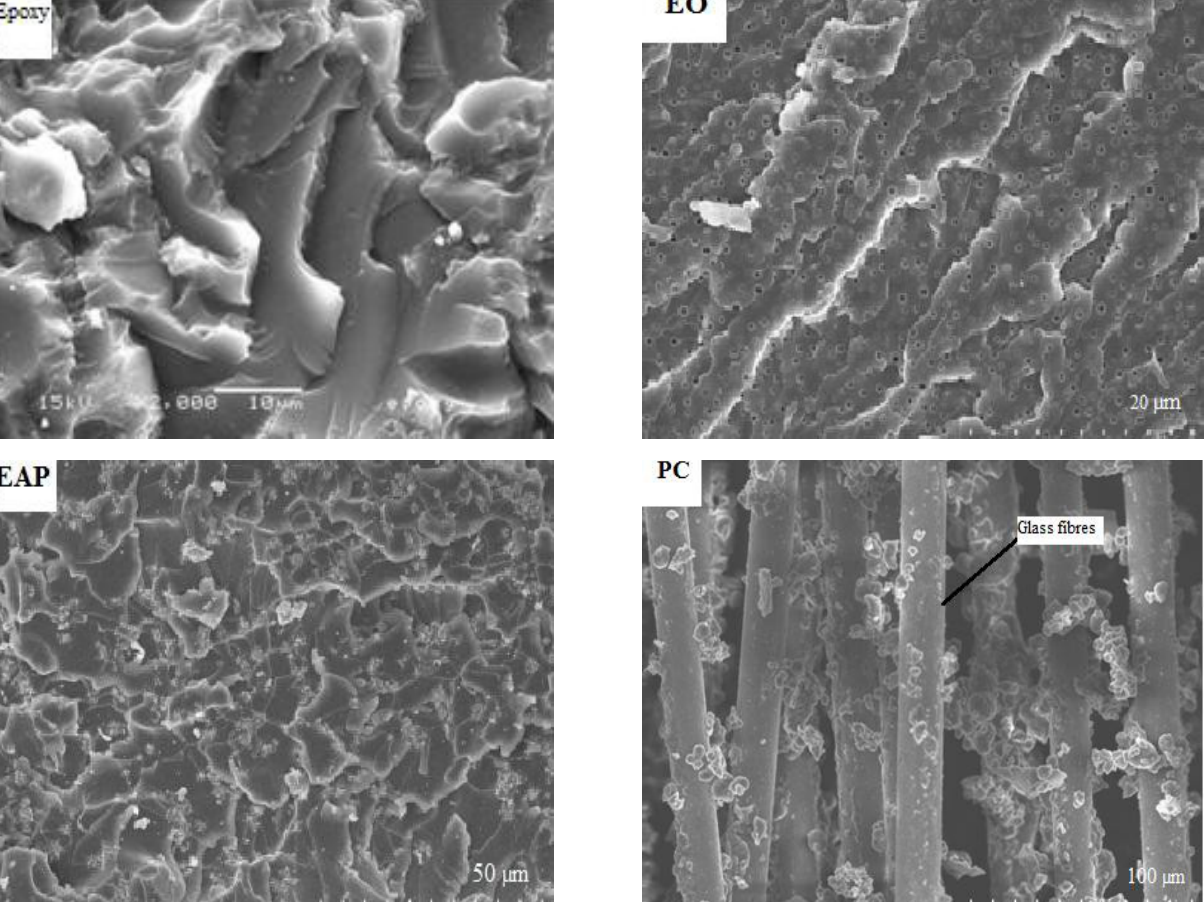
FIG. 7. FE-SEM MICROGRAPHS OF THE SAMPLES: NEAT EPOXY; EPOXY/ EPOXIDIZED LINSEED OIL (EO); EPOXY/ SB 9PHR /CHLORINATED PARAFFINS 9PHR (EAP);